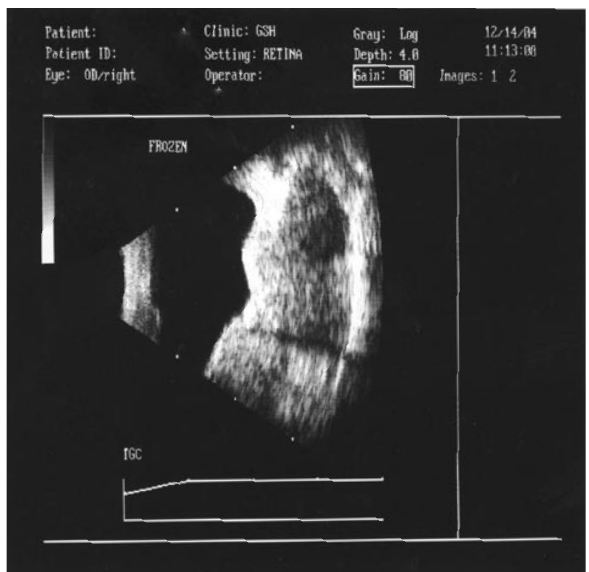
Figure 4. B-Scan showing mass in nasal